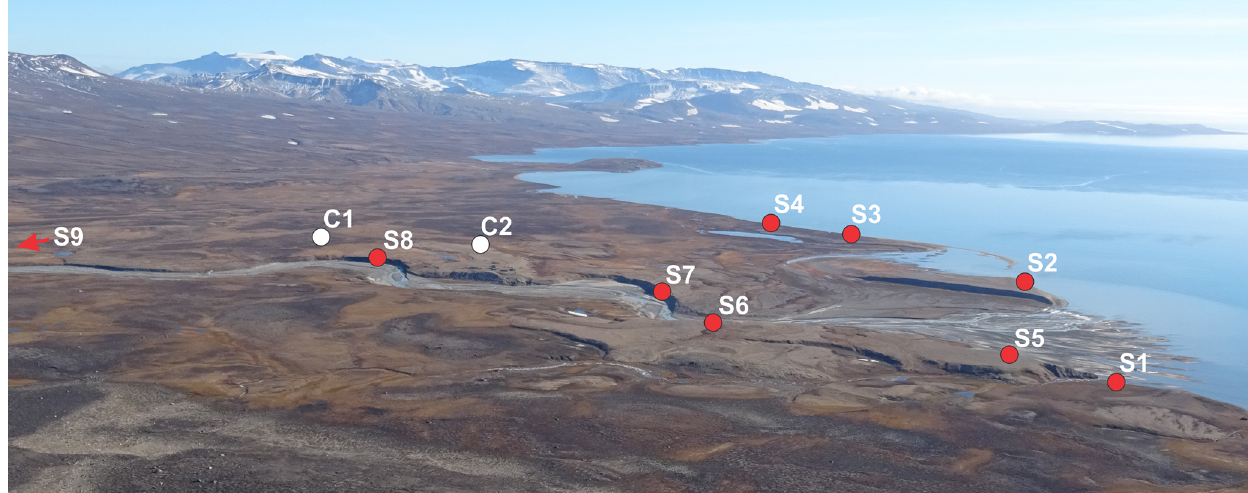
Figure 2. Overview image from the Zackenberg Mountain looking east over the lowlands on 8 September 2016. Site locations are those indicated in Fig. 1. The photo was provided by L. H.